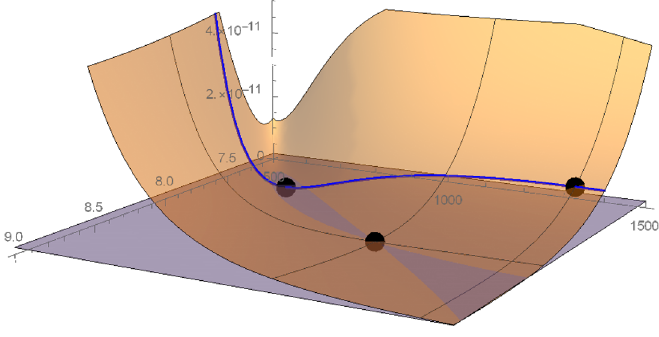
Figure 2 . Total scalar potential as a function of τ s and τ b . The black dots correspond to the de Sitter minimum, the saddle point and the maximum along the weakest direction (the blue curve). The grey plan at V = V highlights the unstable direction for the saddle saddle